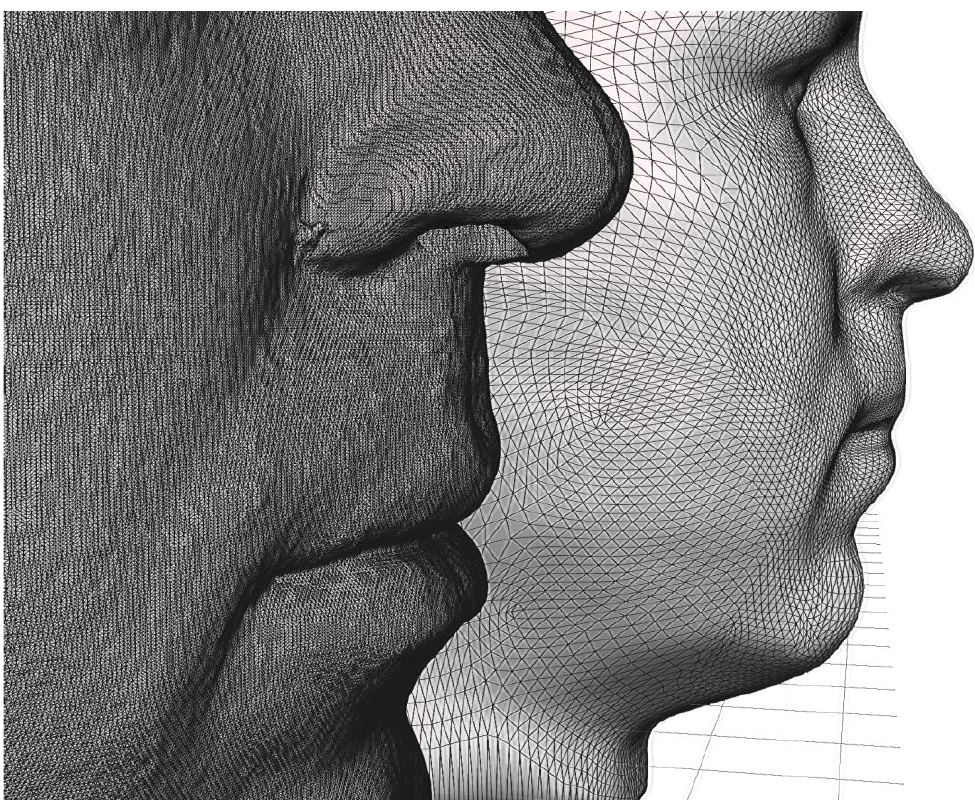
Figure 1. The difference between the polygon resolution of the STL from the CBCT (in the front) and the STL from the face scan (TrueDepth — Bellus3D Dental Pro) in the back is noticeable. The methods presented can be divided into 3